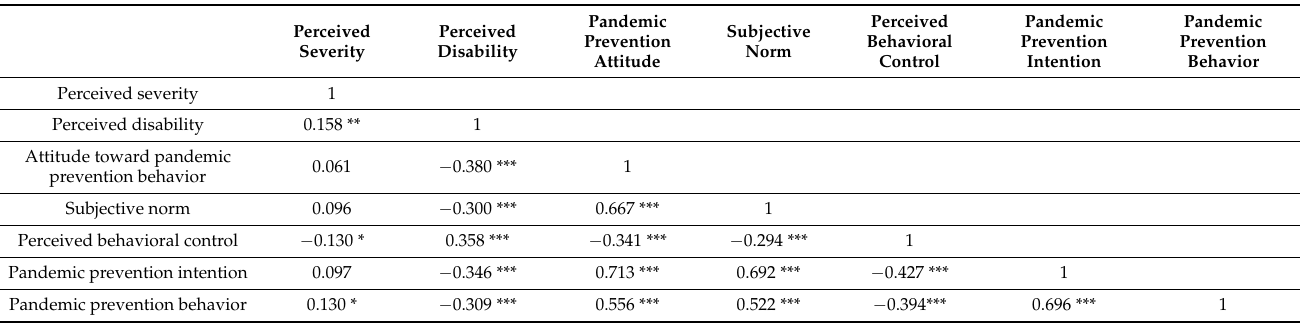
Table 3. Correlation of study